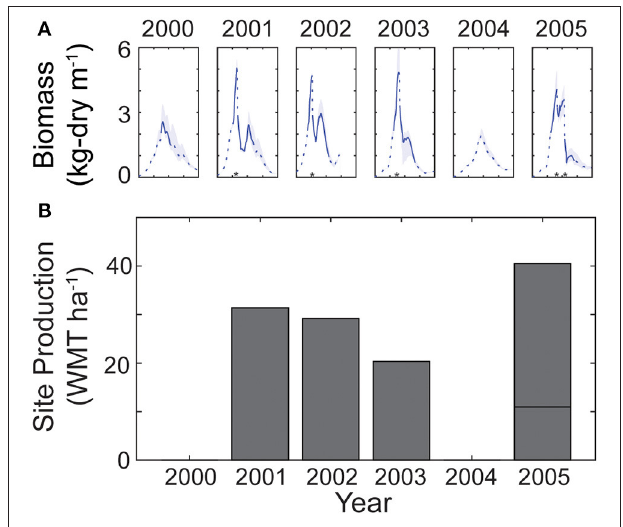
FIGURE 9 | (A) Daily average kelp biomass (kg-dry m -1 line) for six separate years for Simulation D, which includes all within-farm physics, transport, and uptake, as well as a criteria-based harvest (harvests indicated with asterisks). Solid line indicates a formed canopy; dashed line indicates a subsurface kelp farm. Shaded regions represent the full range of biomass within the farm. Ticks on x-axis correspond with January, April, July, and October. (B) Total site production per year (metric tons of wet weight per hectare; WMT ha -1 ). Multiple harvests per year are